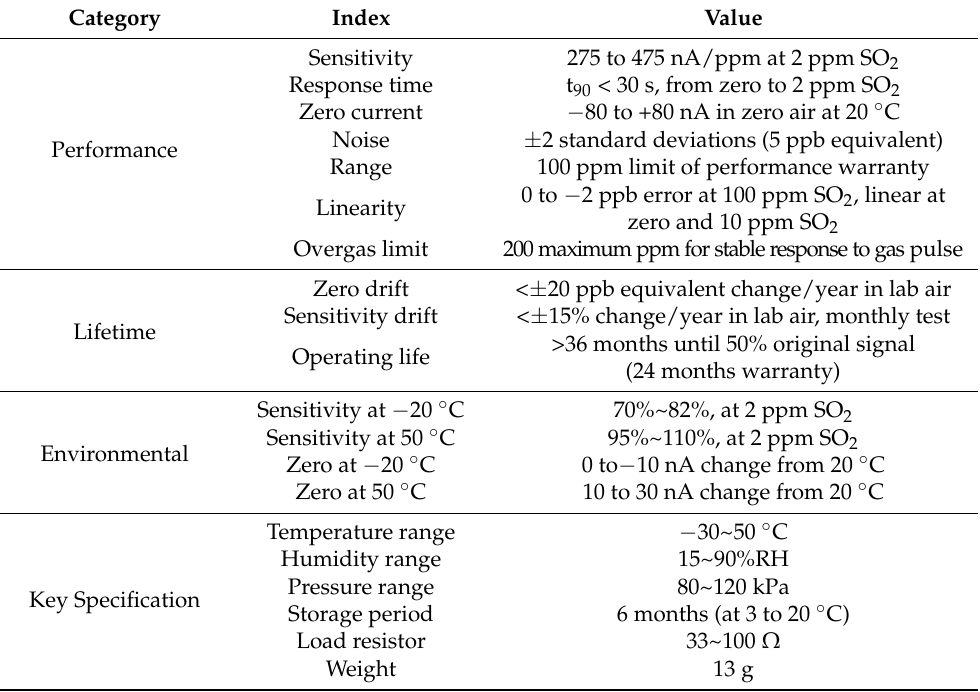
Figure 2. Structure diagram of SO 2 electrochemical gas sensor. Table 1. Performance parameters of SO 2 electrochemical gas sensor.